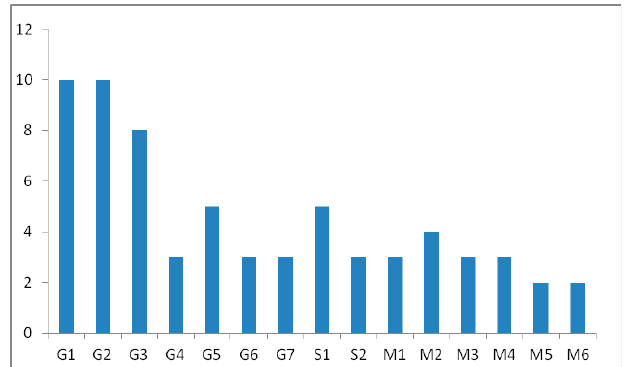
Figure 3. Detection times (days) of the different metabolites monitored in the administration study urine samples collected after oral administration.